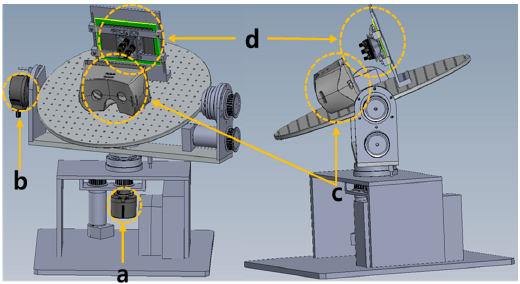
Figure 6. Overall architecture of the photosensor-based latency measurement system: ( a ) a yaw-direction encoder, ( b ) a pitch-direction encoder, ( c ) a HMD system, and ( d ) a plate holding the display of the HMD system.